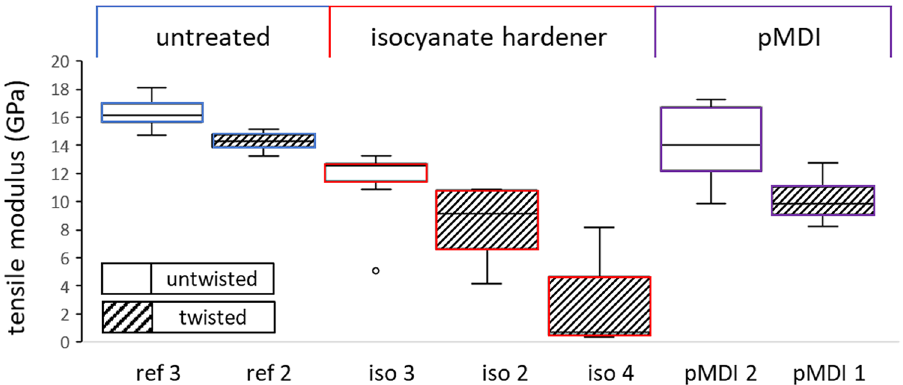
Figure 6. Tensile modulus of twisted and untwisted 2440 dtex samples of untreated (ref) and isocyanate-treated (iso, pMDI) yarns; isocyanate batch with 15 days treatment was additionally indicated (iso 4).